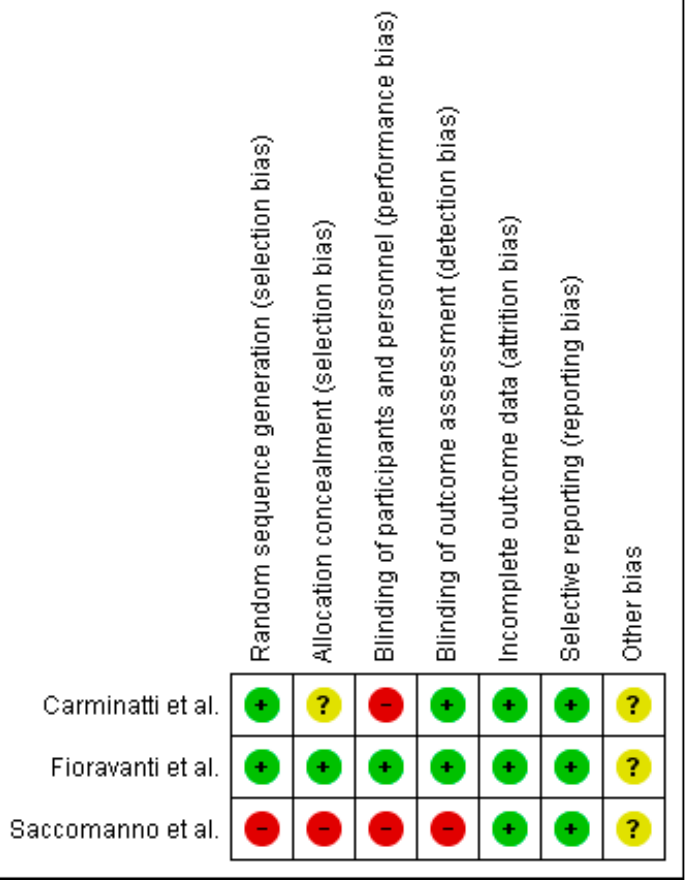
Figure 3. Risk of bias graph. 4. Discussion This systematic review was developed with the aim of finding out the efficacy of MFT in people with ankyloglossia. In view of our results, we can conclude that there is not enough evidence that the MFT is effective on its own because in the articles evaluated it was accompanied by surgery. In addition, the studies were not of good methodological